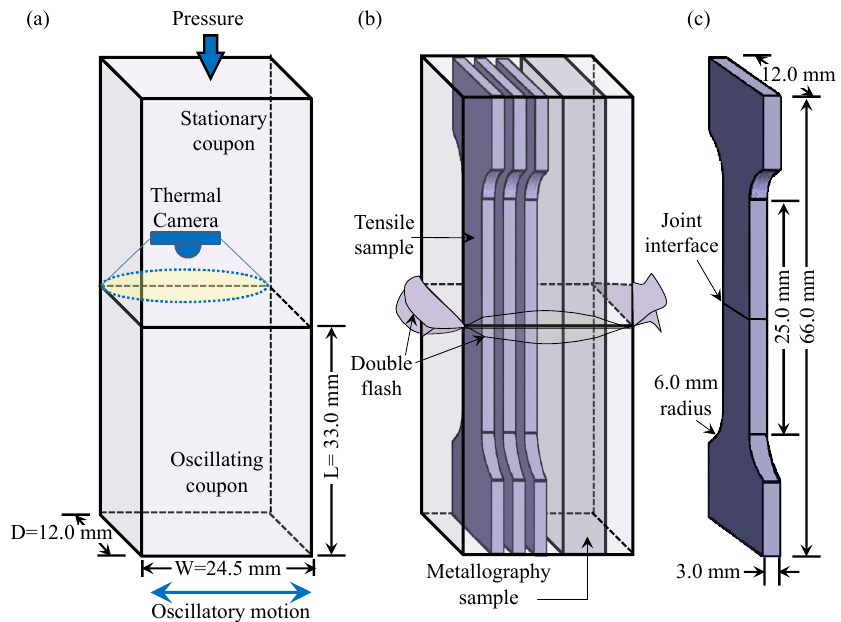
Figure 1. Schematic diagram showing ( a ) the LFW coupon length (L), width (W), and depth (D); ( b ) the machining plan for extracting the metallography and tensile samples; and ( c ) the geometry of the tensile